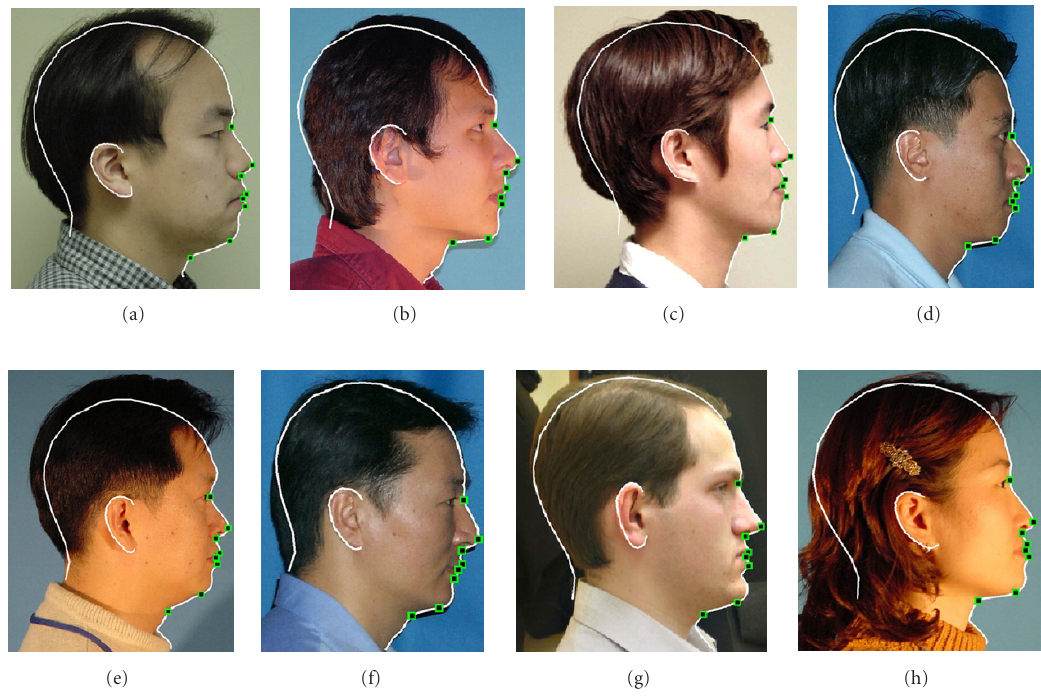
Figure 22: The results of profile curves, profile fiducial points, and ear detection.